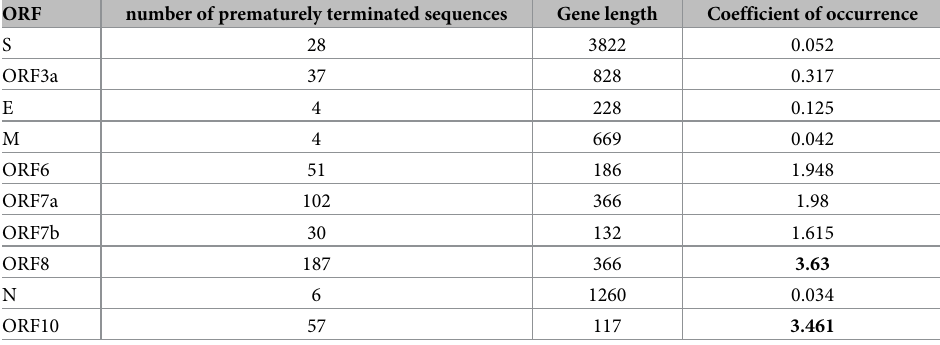
Table 1. The frequency of prematurely terminated sequences per